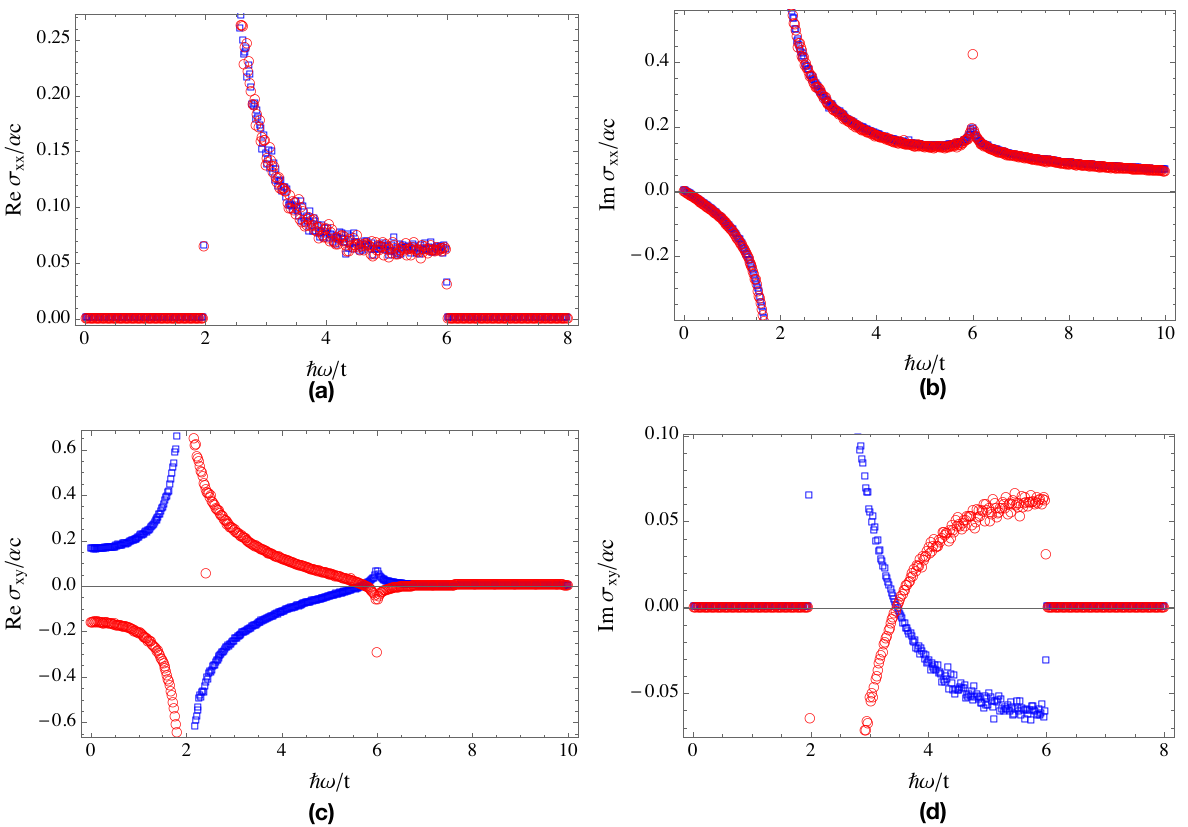
Figure 3. (Color online.) Real-frequency dispersion behavior, shown by curves with blue squares (red circles), of the Chern insulator’s conductivity tensor for u / t = 1 ( u / t = 1) in Equation (29): ( a ) Re σ xx ( ω ) / ( α c ) , ( b ) Im σ xx ( ω ) / ( α c ) , − ( c ) Re σ xy ( ω ) / ( α c ) , and ( d ) Im σ xy ( ω ) / ( α c ) as functions of ¯ h ω / t (horizontal axis). Figure reproduced from Ref.